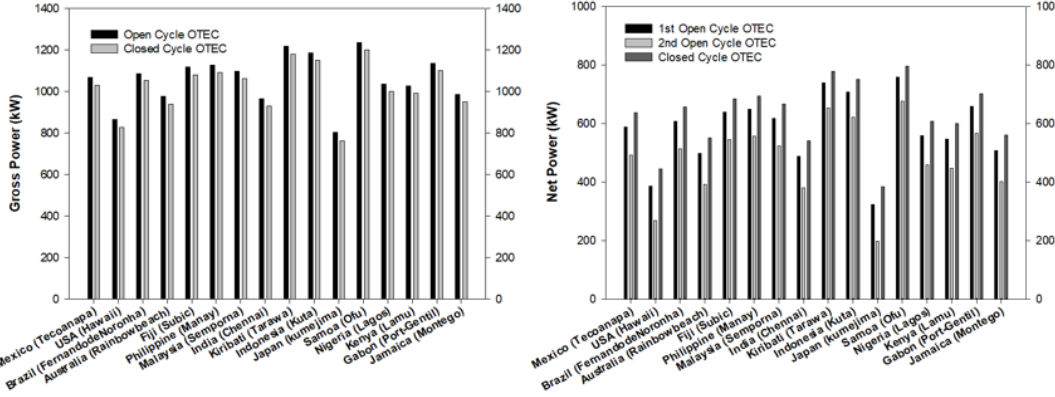
Figure 7. Gross power and net power for OTEC cycle in application areas.